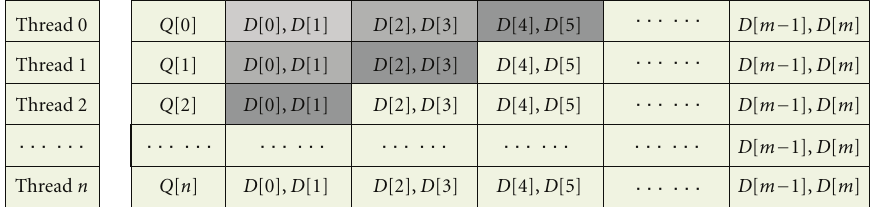
Figure 10: Alignment matrix calculation with vector variable